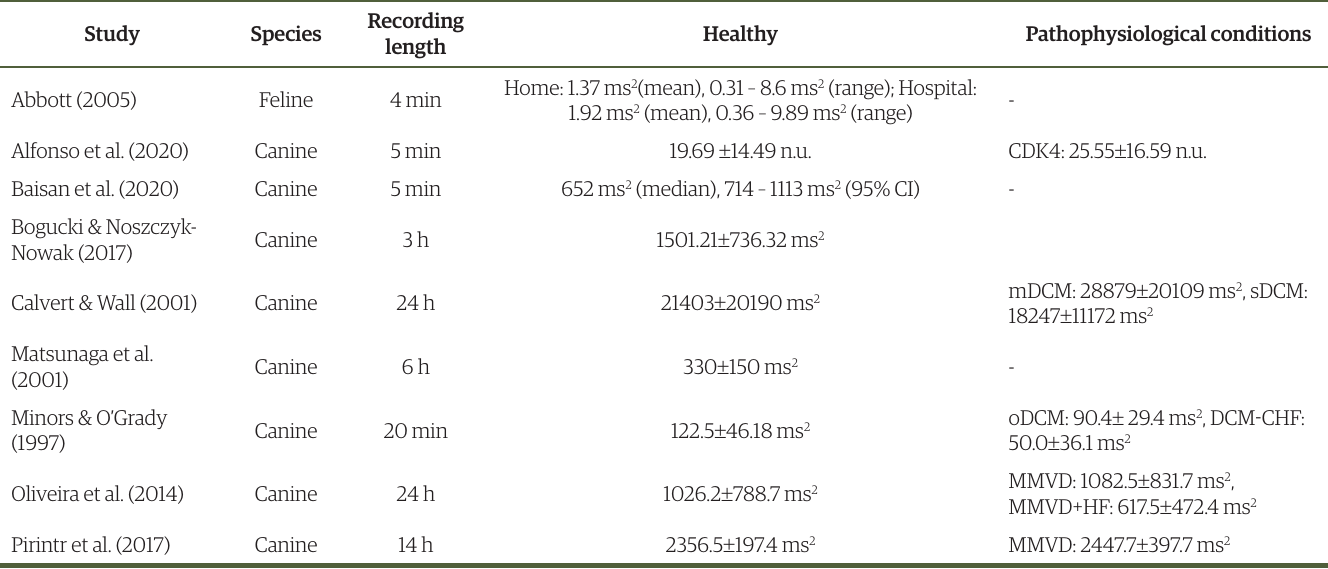
Table 8. Summary results of selected studies from the literature, depicting the recording length for data acquisition and the LF values for healthy animals or those presenting pathophysiological